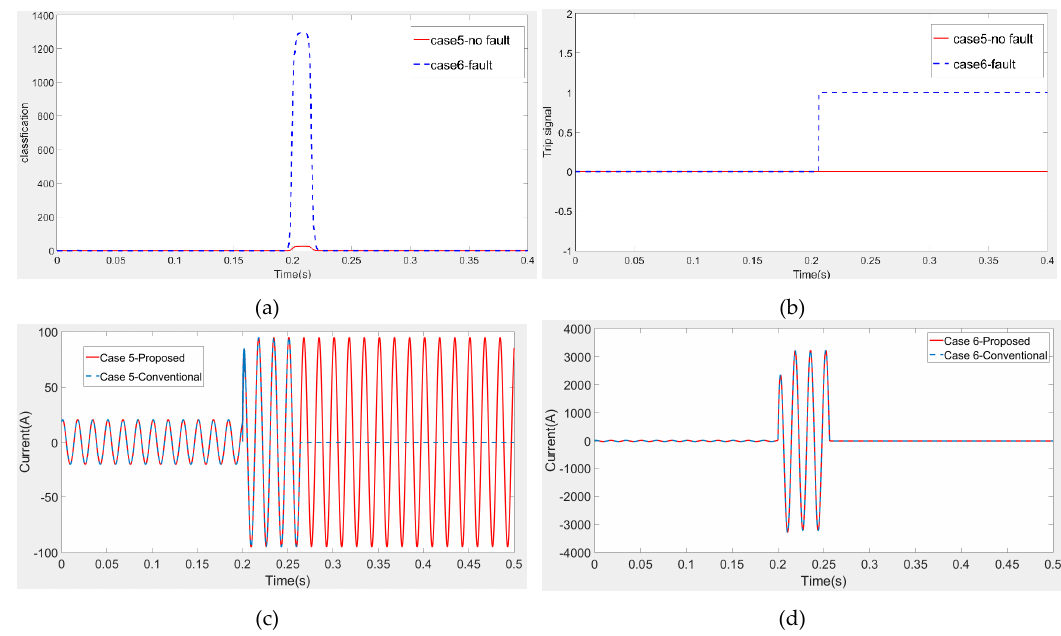
Figure 19. Simulation results of case 5 and 6. ( a ) Calculation result of classification value; ( b ) Trip signal; ( c ) Current flowing in the Y line in case 5; ( d ) Current flowing in the Y line in case 6.